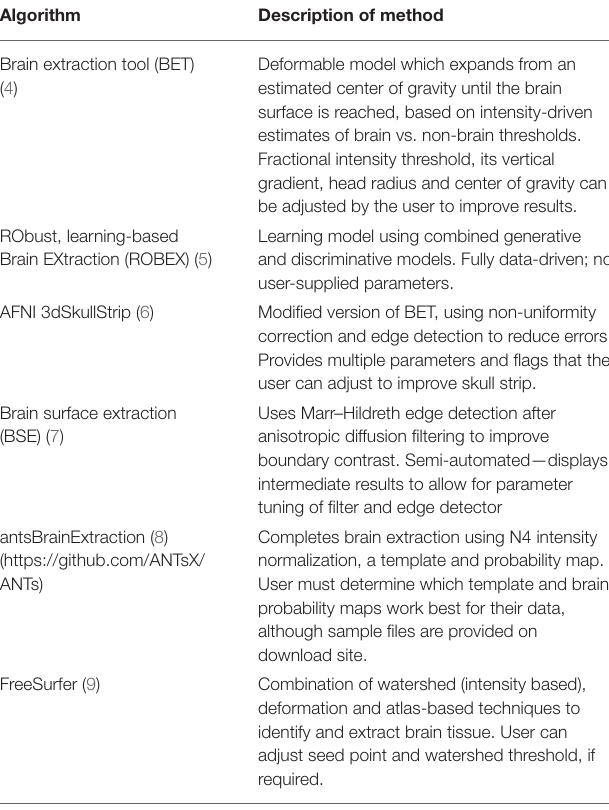
TABLE 1 | Summary of several commonly used skull-stripping algorithms for T1-weighted images.